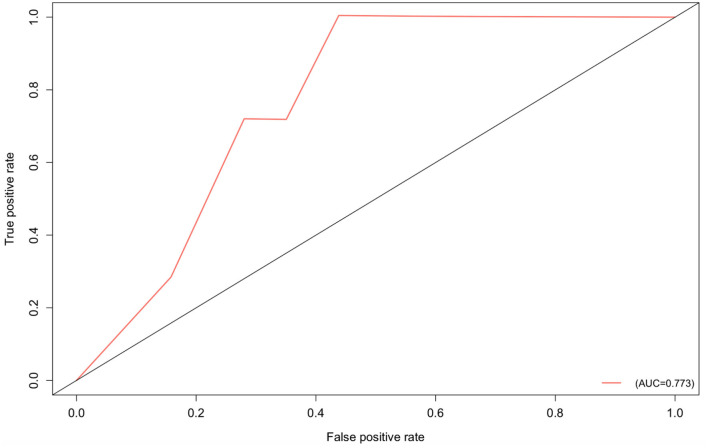
ROC and AUC of RSF model to predict VT/VF post-diagnosis.